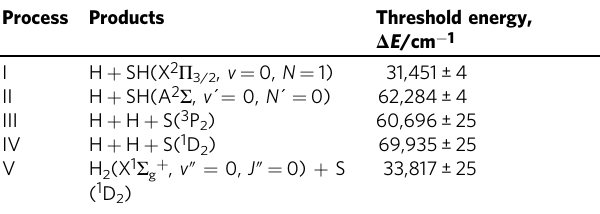
Table 1 Thermochemical thresholds for spin-allowed fragmentation processes I – V of H 2 S, derived using literature values for the bond dissociation energies D 0 °(HS – H) 69 , D – H) 70 , D – H) 71 and the electronic term values 0 °(S 0 °(H T